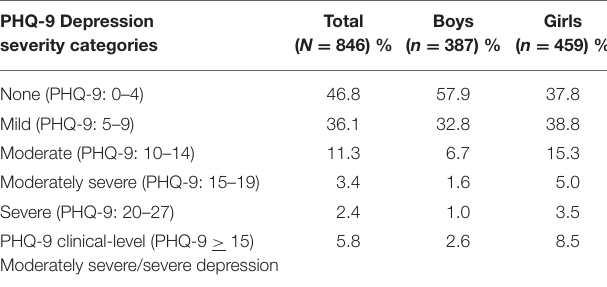
TABLE 3 | Originally proposed PHQ-9 severity categories; total sample and by